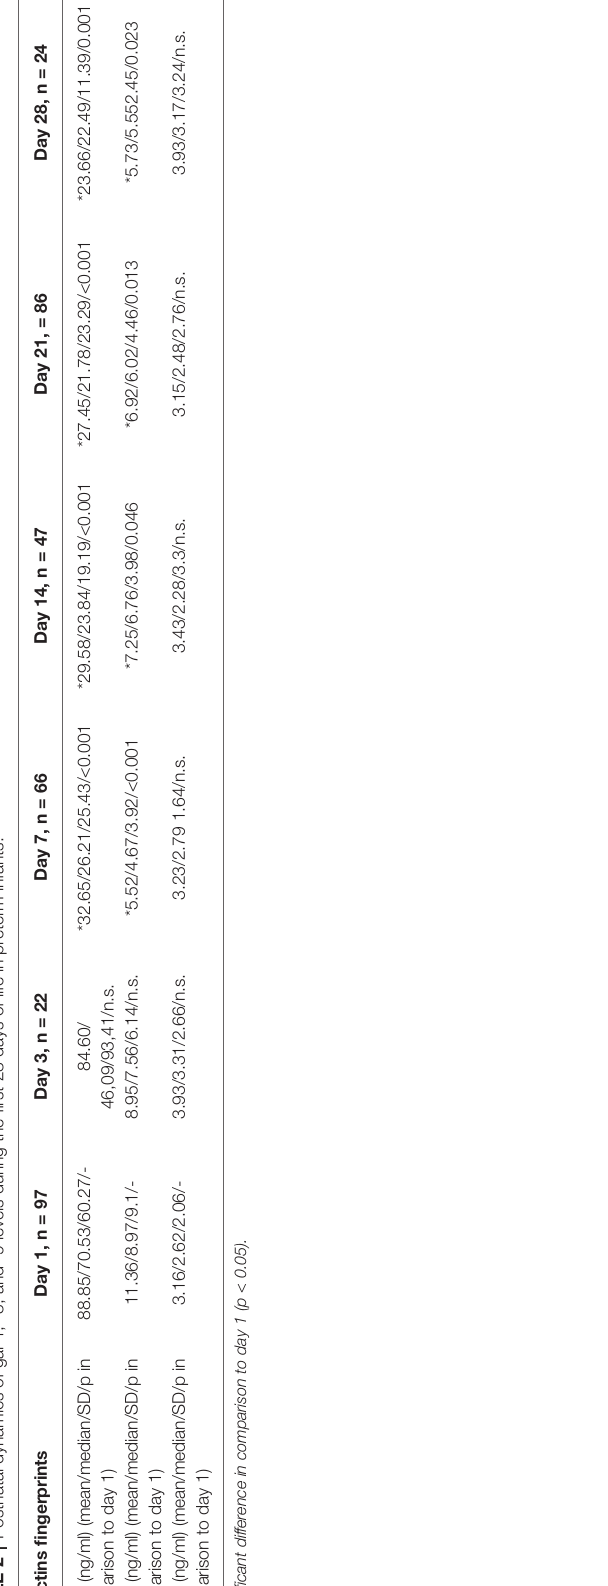
gal levels. Using single comparisons, we found higher levels of galectin 1 and 9 in infants born to mothers with severe AIS (n = 23) during the fi rst day of life ( Figure 2 ) compared to infants born to mothers with suspected (n = 37) or without AIS (n = 37). At day 1 of life, for example, gal-1 levels were remarkably increased in infants born to severe AIS ( Figure 2A ; mean ± SD; severe AIS: 128.5 ng/ml ± 61.5, suspected AIS: 89.5 ng/ml ± 69.3, no AIS: 63.5 ± 34.9; P < 0.001), which was also observed for gal-9 ( Figure 2E ; severe AIS: 4 ng/ml ± 1.6, suspected AIS: 3 ng/ml ± 1.9, no AIS: 2.8 ± 1.8; P = 0.011). This difference was not evident for gal-3 and on day 3 of life ( Tables 2B, D, F ).